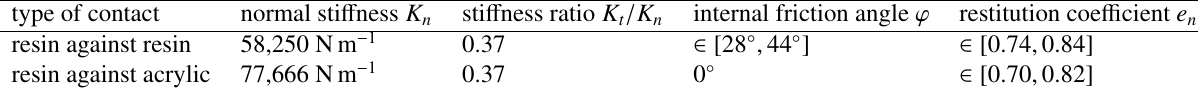
Table 1. Contact parameters as measured by the JGS 1 - Intervals give the range of the distribution used for the parameter